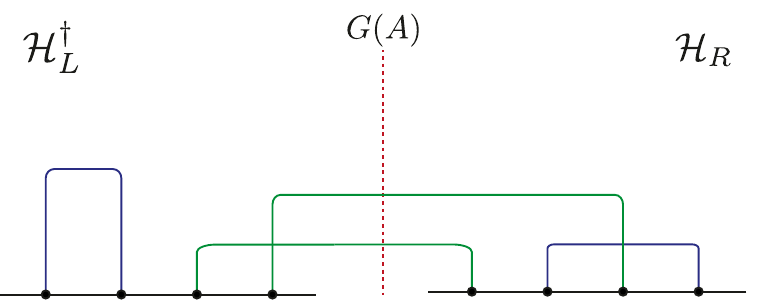
( G ( A ) σ R,I 1 σ R,I 2 σ R,I 3 σ R,I 2 σ L,I 3 σ L,I 1 σ L,I 4 σ L,I 4 H † L ⊗H R . Note that the ) , contributing to m 4 , 4